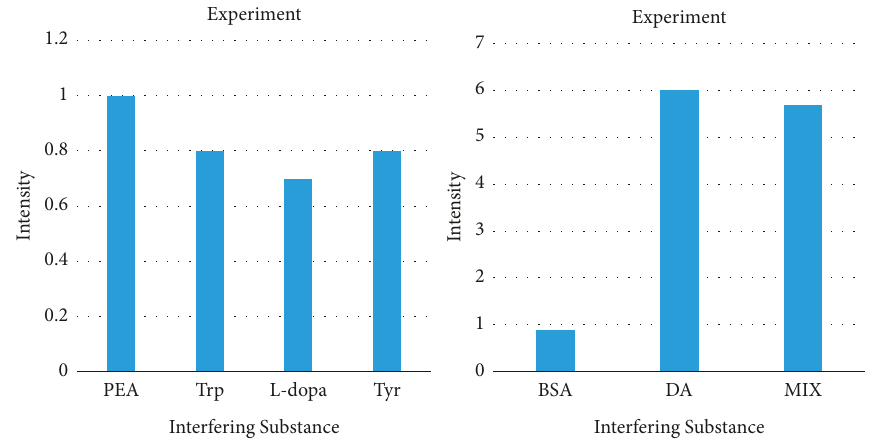
Figure 6: Selectivity experiment of DA detection based on SERS